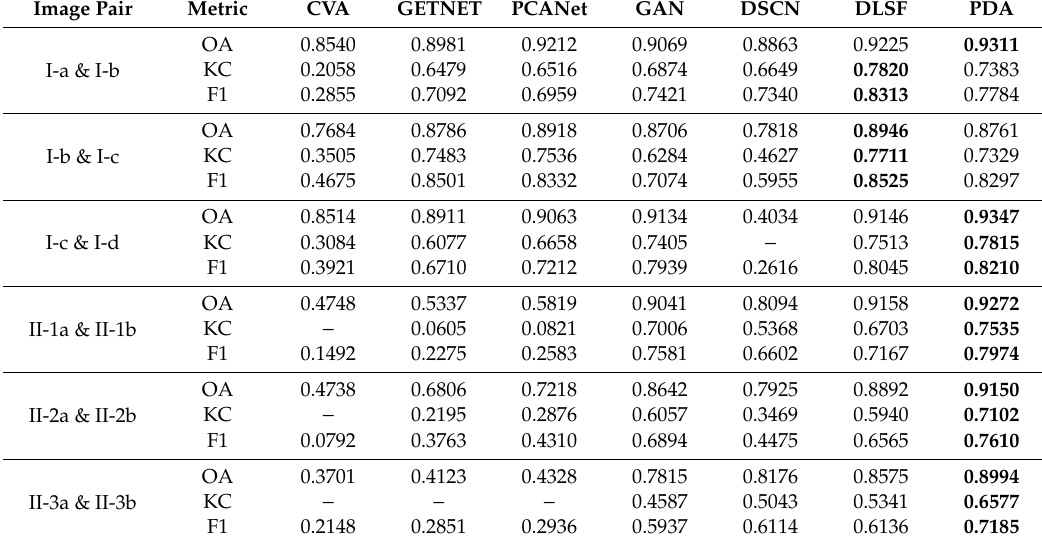
Table 3. Quantitative results of the comparative methods. The best values are in bold, and ( − ) denotes that the value is